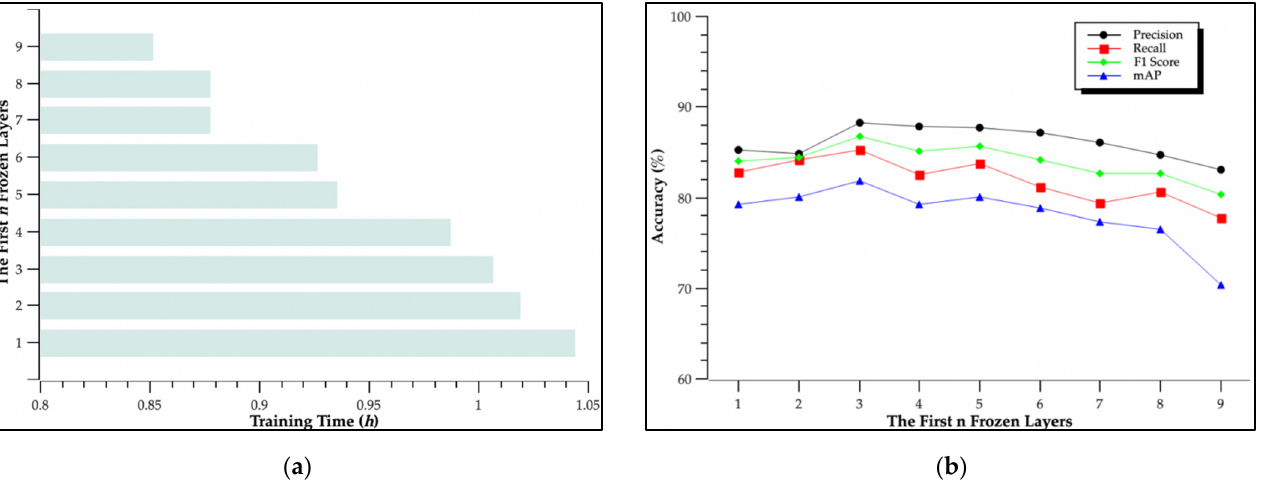
Figure 9. Performance of deep transfer learning using different frozen layers on the RSDams validation set. ( a ) Column graphs for training time by different frozen layers. ( b ) Line and symbol graphs for accuracy using different frozen layers. Black circles represent the index of precision. Red squares represent the recall rate. Green diamonds represent the F1 score. Blue triangles represent mAP.